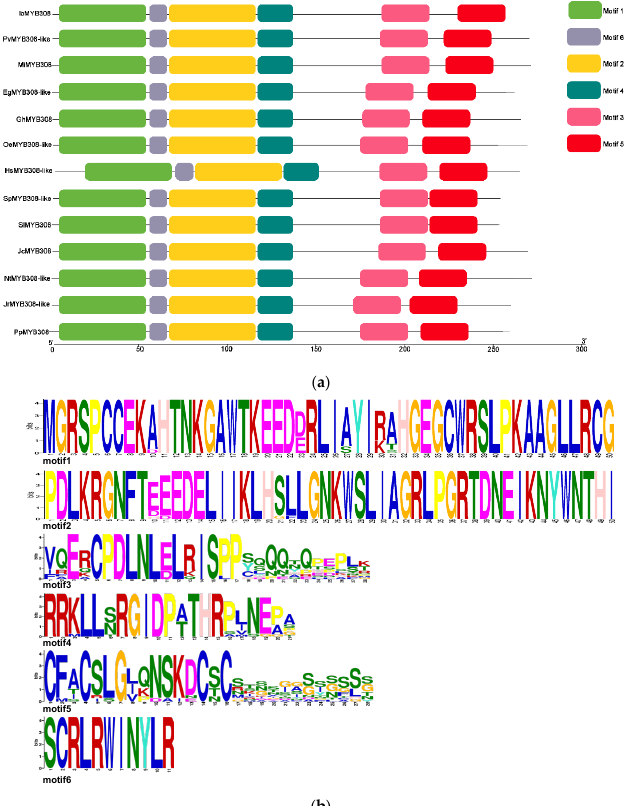
Figure 2. Motifs in IbMYB308 and MYB308 or MYB308-like species. ( a ) Motif location. ( b ) The width and amino acid sequence of conservative motifs.